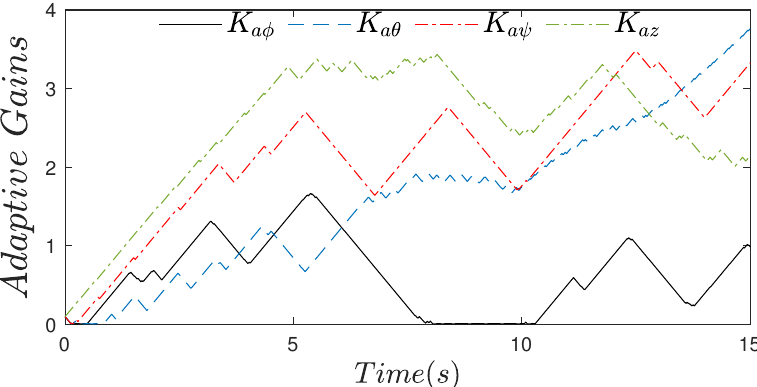
Figure 11. Hovering. Adaptive control gains under external